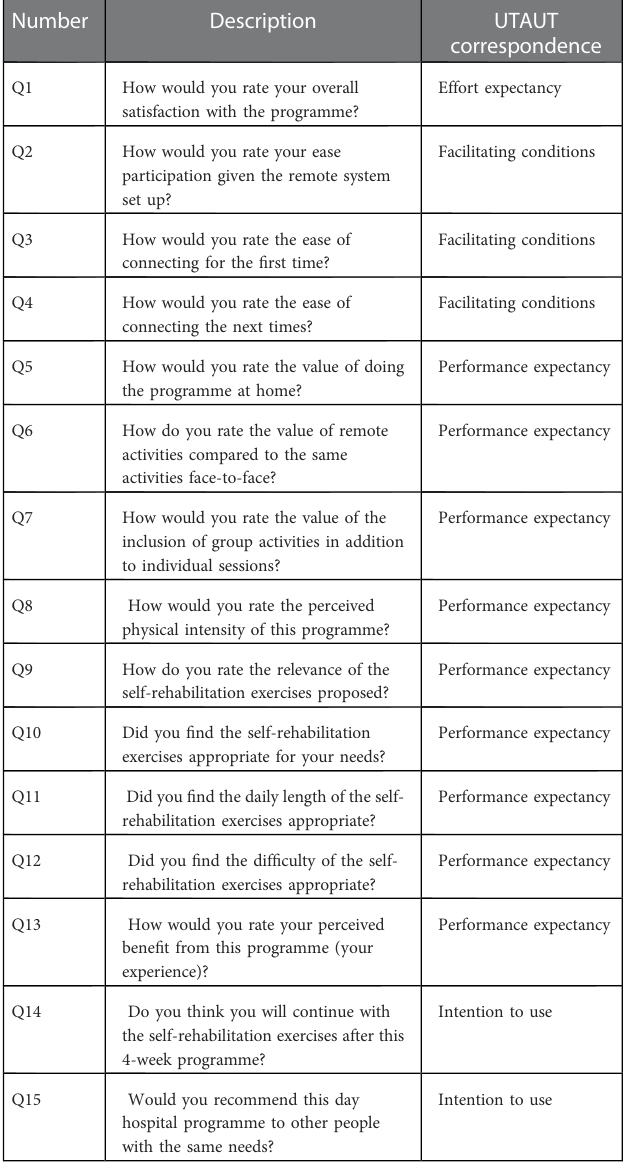
TABLE 1 Presentation of the questionnaire – link between items and UTAUT